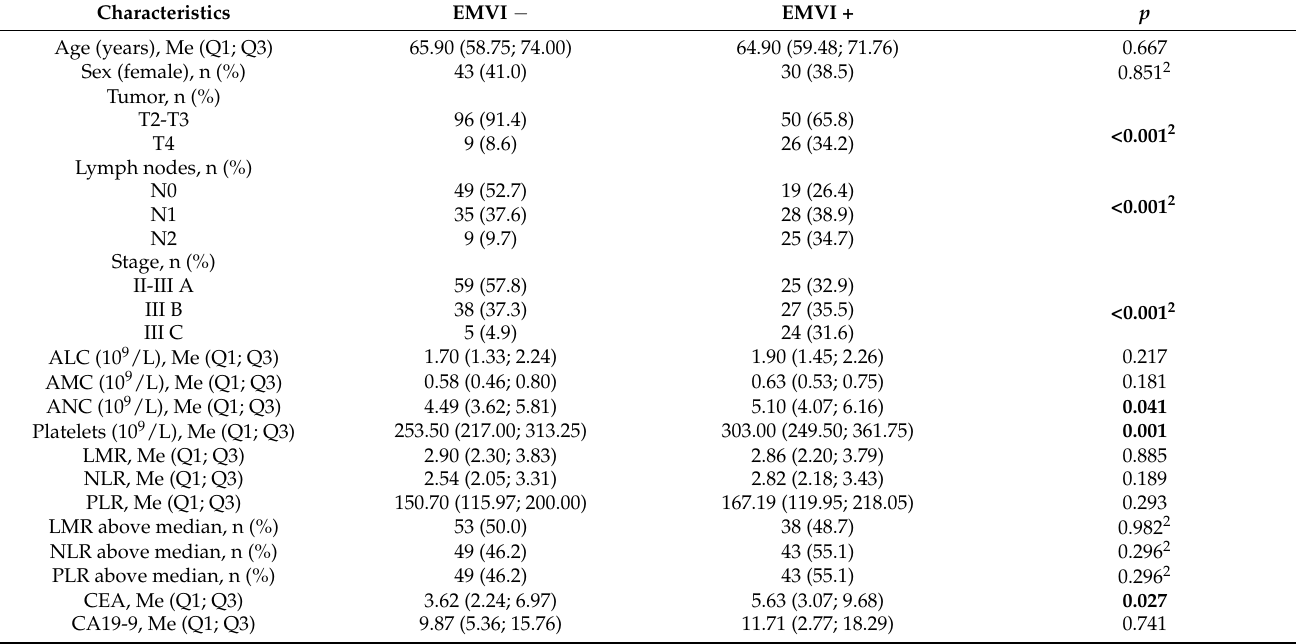
Table 3. Comparison of characteristics between EMVI